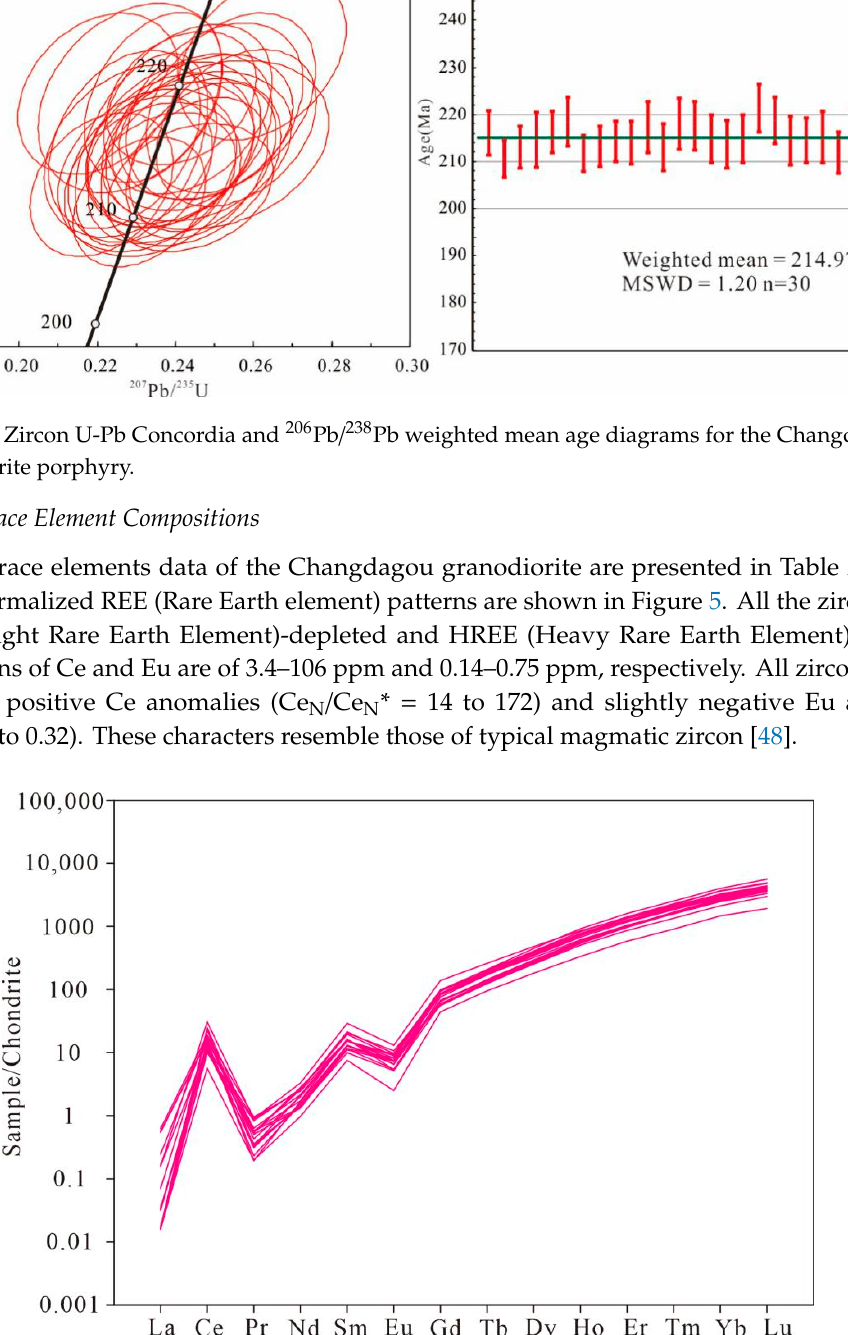
Figure 6. Ce N /Ce N *-related binary diagrams of zircon grains for the Changdagou, Pulang and Lannitang granites from Yidun arc. ( a ) log f O 2 vs. temp. °C diagram, where log f O 2 value was calculated by the method of Trail et al. [34]; ( b ) Histogram of oxygen fugacity; ( c ) Ce N /Ce N * vs. Eu N /Eu N * plot, where Ce N * is calculated by fitting method; ( d ) Histogram of 1000 (Eu N /Eu N *) vs. Data are as listed in Table A1.